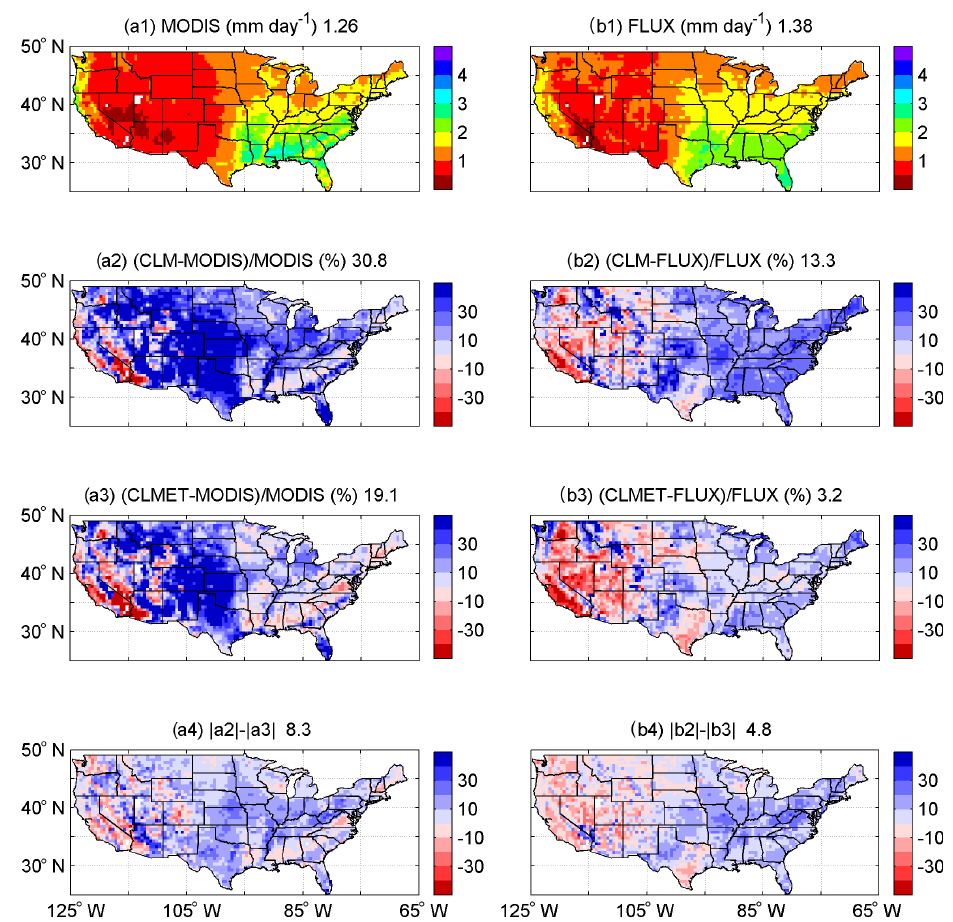
Figure 5. Mean annual ET from (a1) MODIS, (b1) FLUXNET-MTE, the relative differences between (a2) the CLM and MODIS, (b2) the CLM and FLUXNET-MTE, (a3) CLMET and MODIS, and (b3) CLMET and FLUXNET-MTE, and the differences between (a4) the absolute value of (a2) and the absolute value of (a3) , and (b4) the absolute value of (b2) and the absolute value of (b3) during the period 2000–2011. Numbers in titles are CONUS-averaged